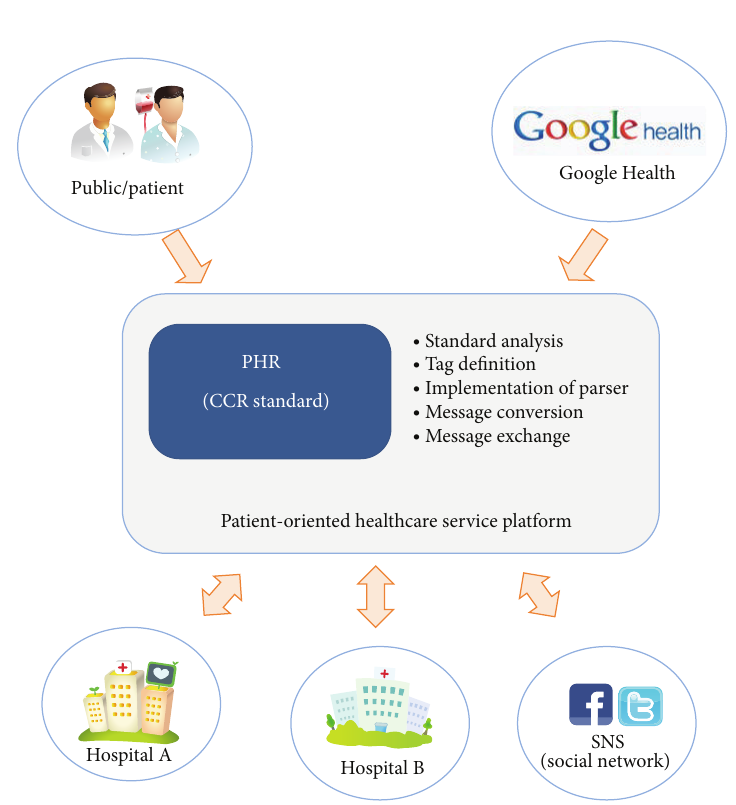
Figure 9: PHR exchange service